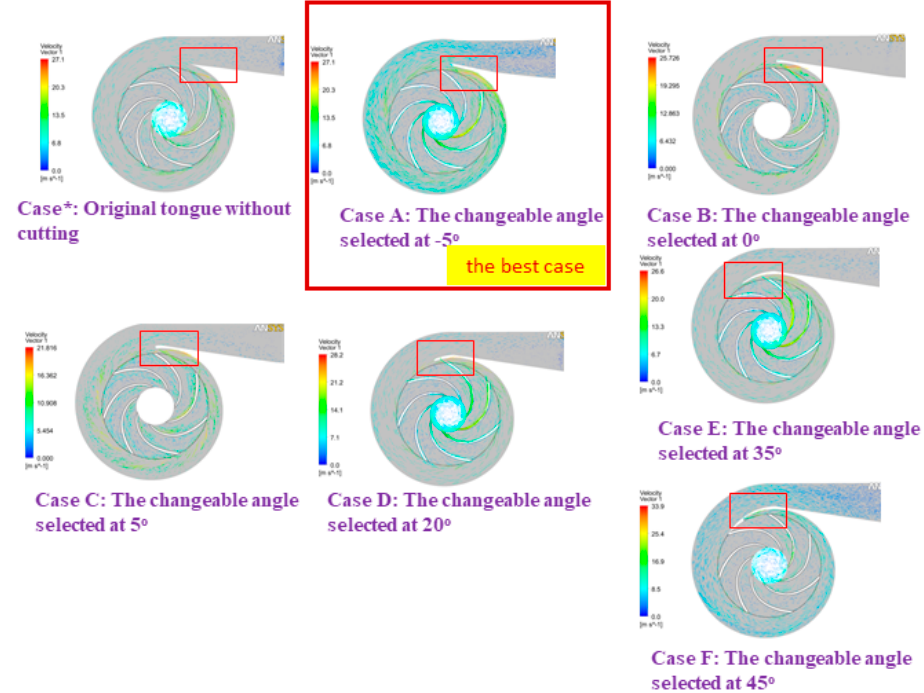
Figure 14. A comparison of the velocity streamlines at different angles.